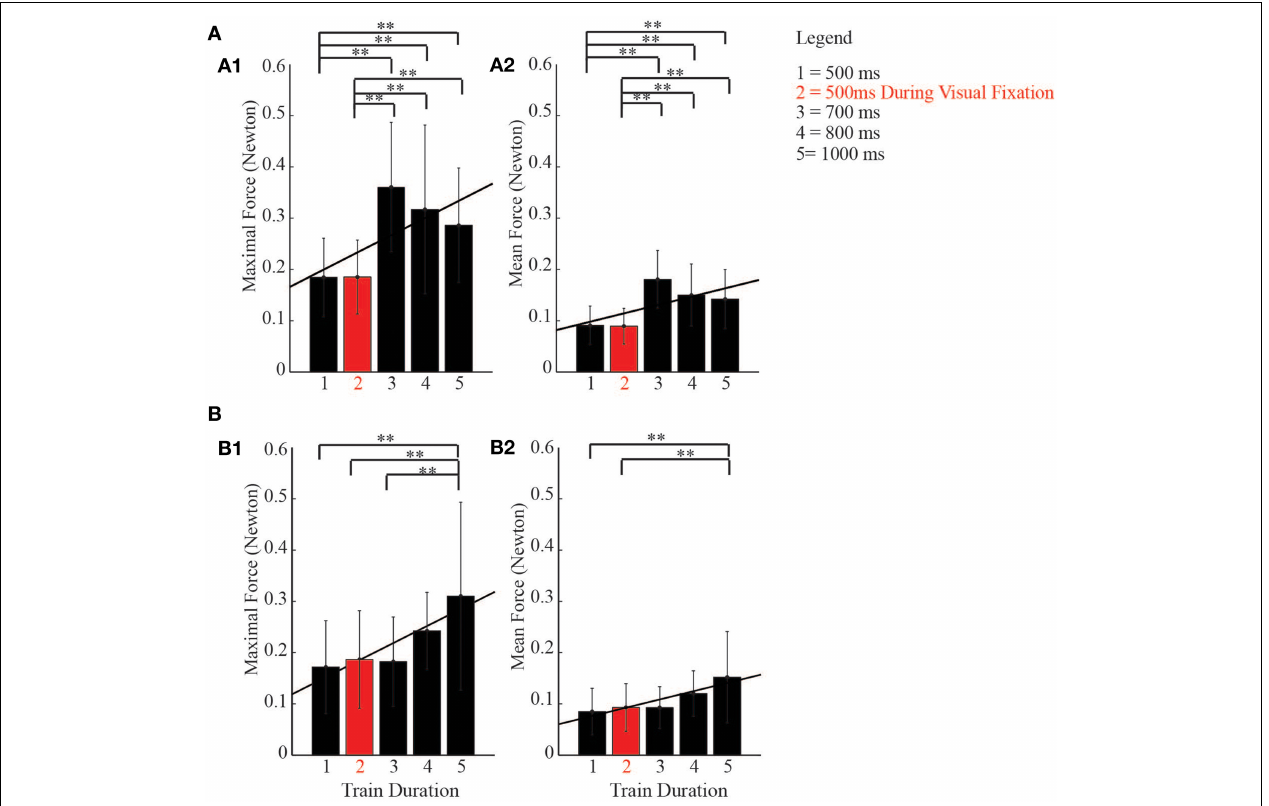
FIGURE 10 | Relationship between duration of stimulation and neck activity. (A) histograms show a linear correlation (Pearson, black line) between durationofstimulationandneckforcesexertedbythemonkeys’headduringthe